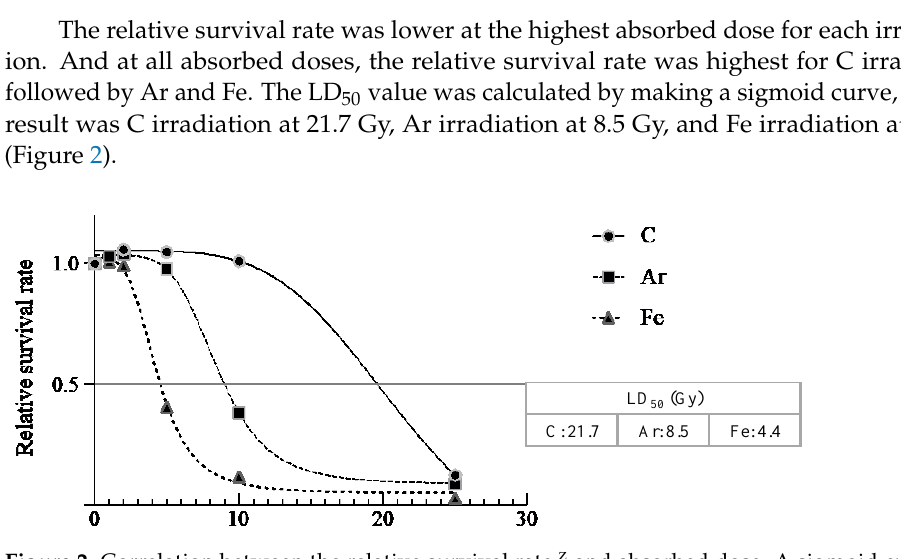
Figure 2. Correlation between the relative survival rate z and absorbed dose. A sigmoid curve was created using GraphPad Prism 9 and LD 50 values were calculated. Numbers in the squares indicate the LD 50 value. z Relative value when the survival rate of the nonirradiated plants is set to 1.